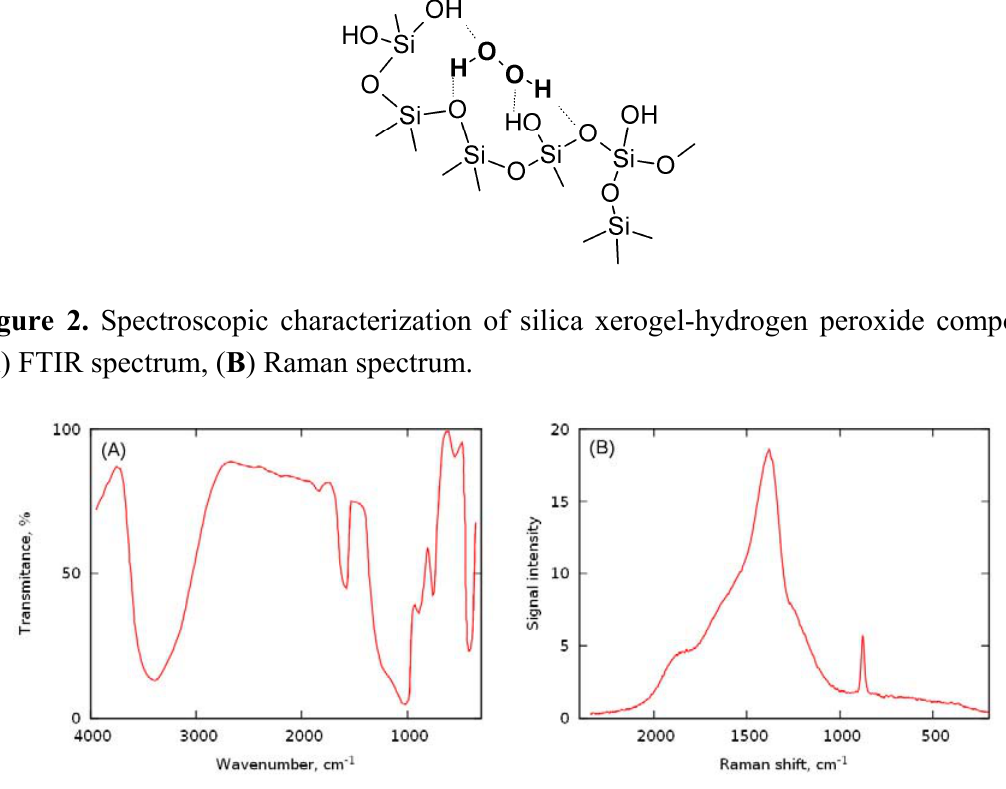
Figure 1. A simplified structure of silica xerogel-hydrogen peroxide composite [7,8].